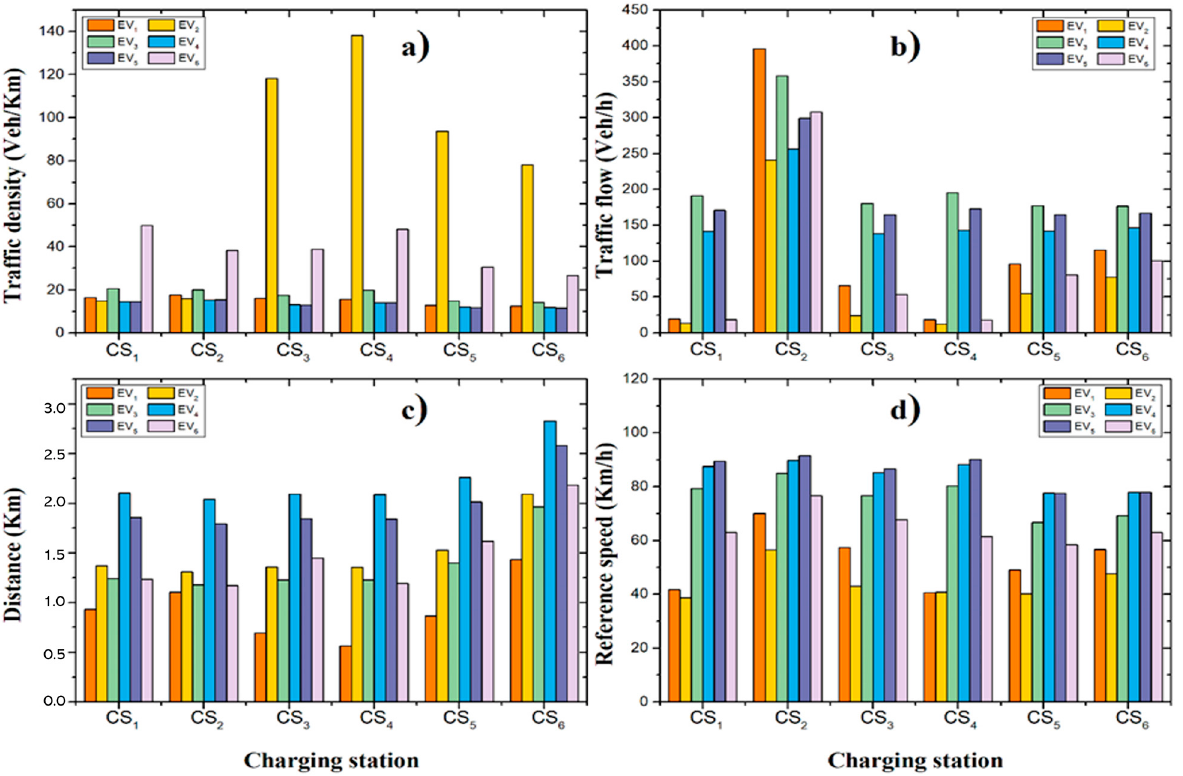
Figure 9. Traffic conditions data. ( a ) Traffic density ( b ) Traffic flow ( c ) Distance ( d ) Reference speed.